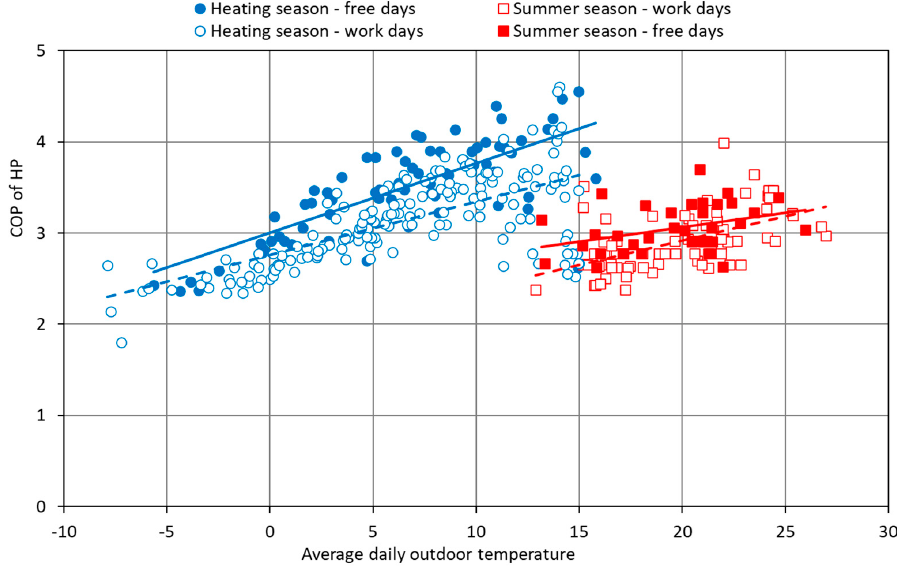
Figure 12. Seasonal dependencies of COP for work days and free days.